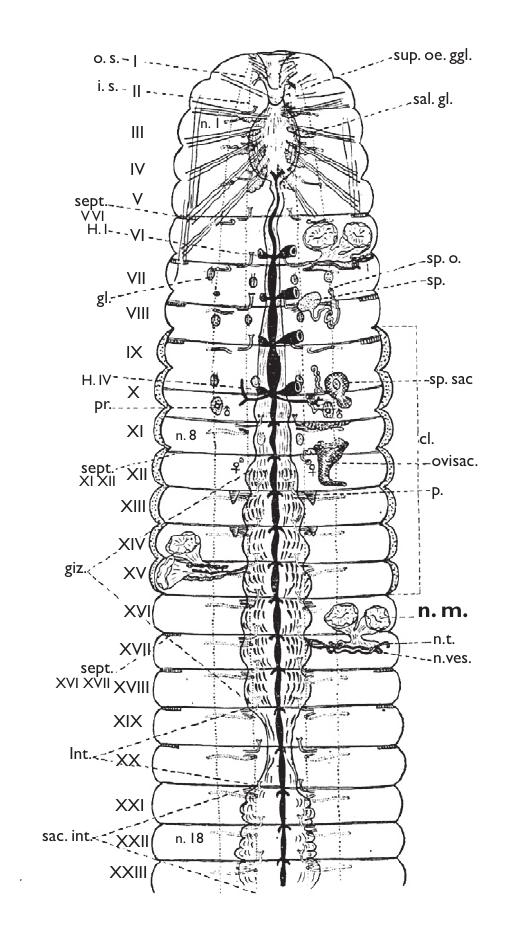
Figure 3. D. hattamimizu detailed internal anatomy showing the disputed paired nephridial funnels (“ n.m. ”) sketched for only three of the nephridia (after Hatai, 1930: fi g.